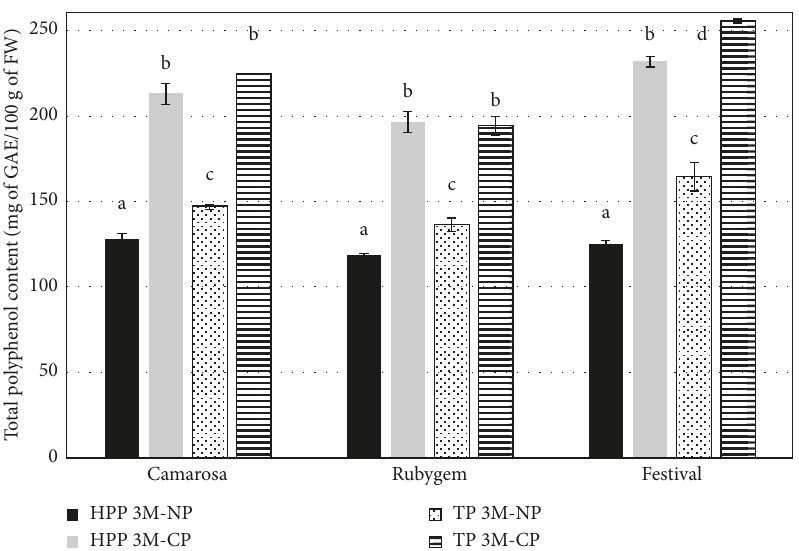
Figure 2: The effects of copigmentation on total phenolic content following three months of refrigerated (4 ° C) storage of HPP and TP strawberry puree samples. CP-3M: copigmented samples and NP-3M: non-copigmented samples stored for three months at 4 ° C. Different letters within a group designate a significant difference ( p 0 . <